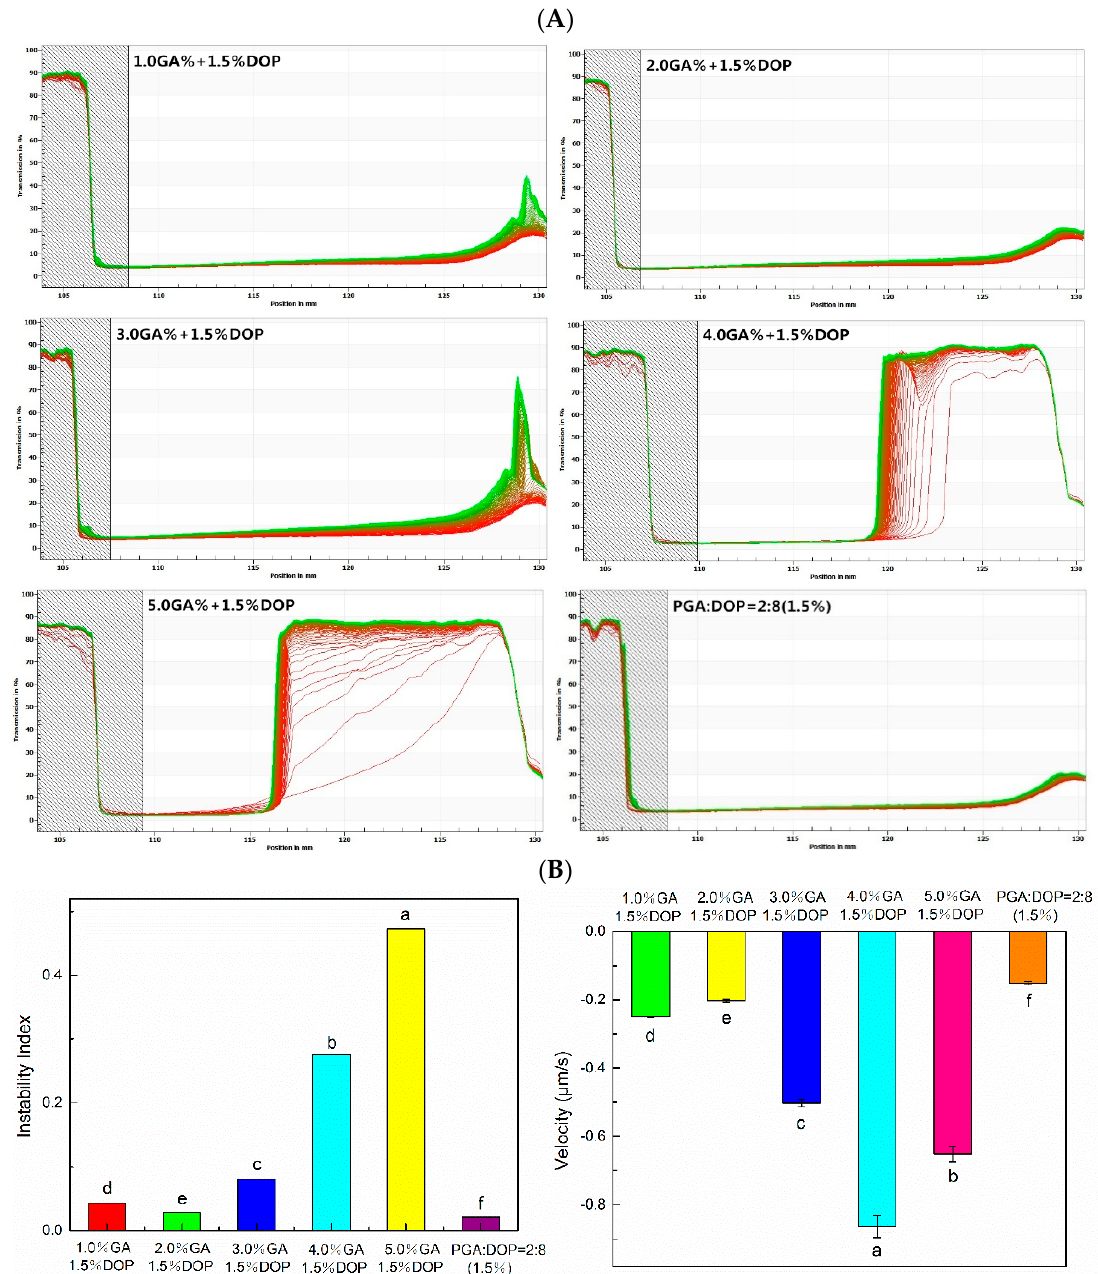
Figure 10. ( A ) Light transmittance curve. ( B ) Instability analysis and interface tracking analysis. The analysis range is from the meniscus to the bottom; a–f indicate significant differences ( p < 0.01).